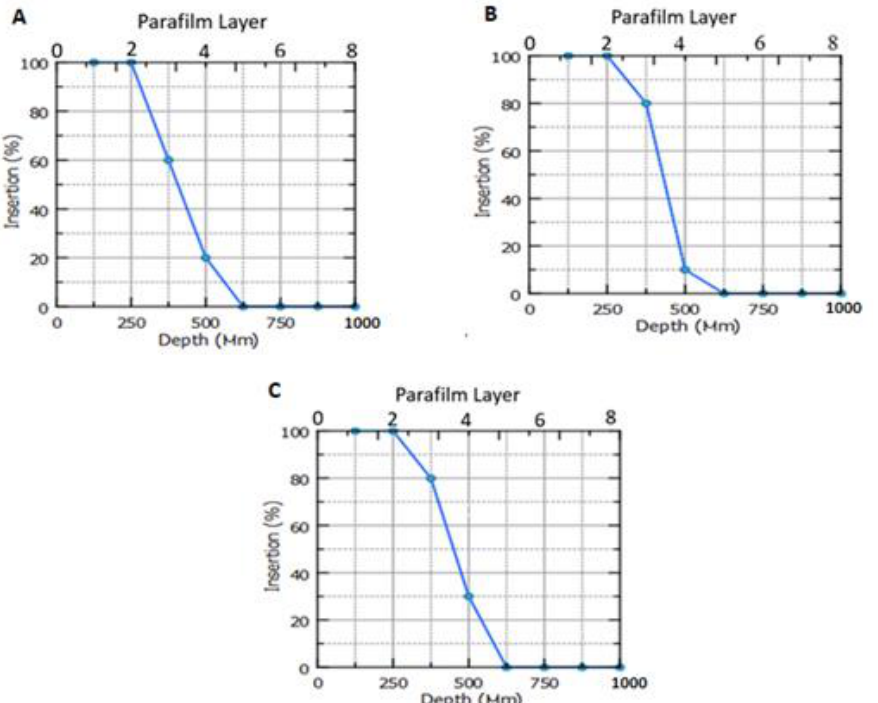
Figure 9. Parafilm™ insertion test for ( A ) MN-1, ( B ) MN-2, and ( C ) MN-3 following a manual force application (Means ± SD, n = 3).